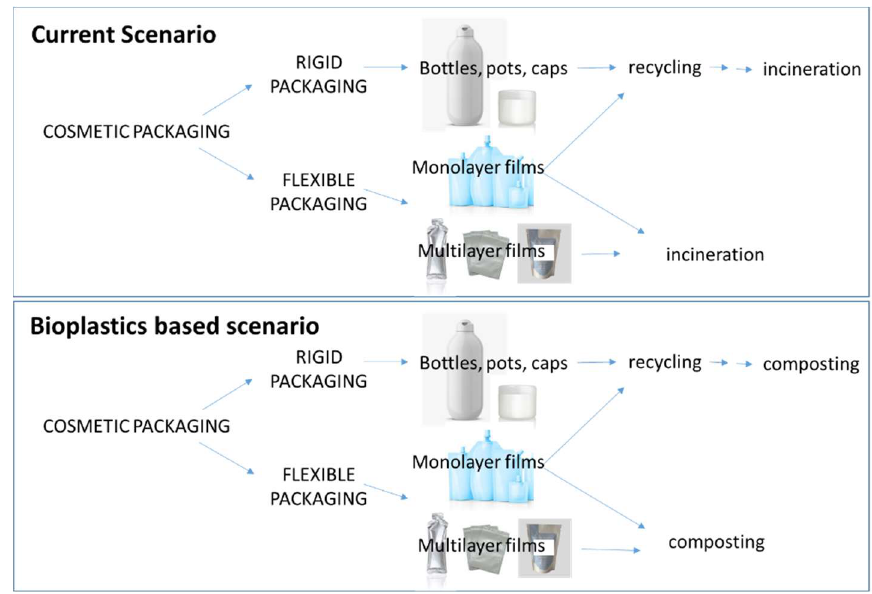
Figure 1. General waste management of cosmetic packaging: current and bioplastics-based scenarios.